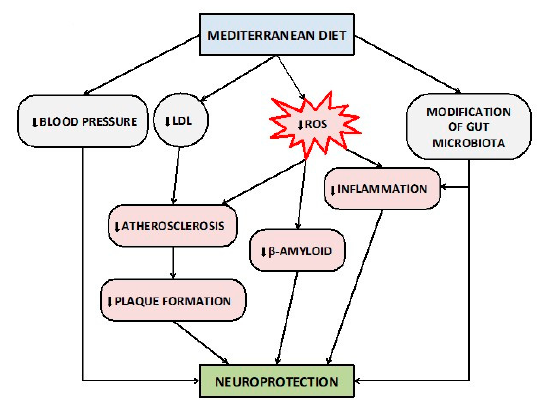
Figure 1. Proposed protective mechanisms of Mediterranean diet on brain health and cognitive functions. Abbreviations: LDL, Low-Density Lipoprotein; ROS, Reactive Oxygen